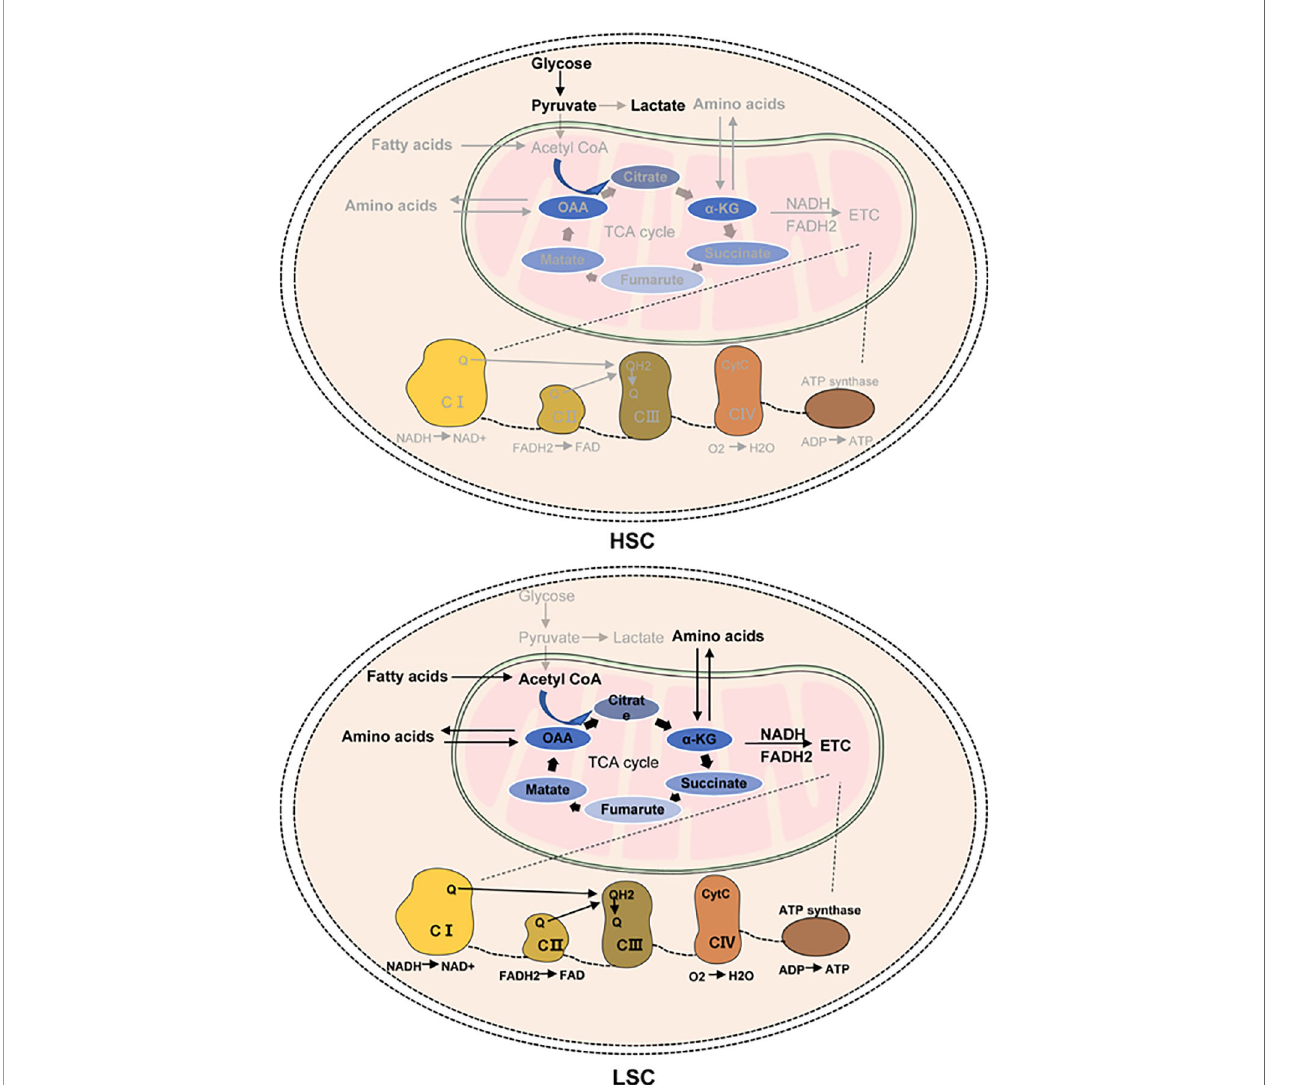
FIGURE 1 | The energy metabolism in HSCs and LSCs. LSCs mainly depend on OXPHOS for energy demand. OXPHOS is a fundamental mitochondrial process, linking the tricarboxylic acid (TCA) cycle to the production of ATP via the electron transport chain (ETC). In LSCs, glucose cannot enter the TCA cycle. Amino acids enter the TCA cycle through conversion to the TCA cycle intermediates (such as oxaloacetate (OAA) and alphaketoglutarate ( a -KG)). Fatty acids are converted to acetyl-CoA through b -oxidation in the mitochondria. The increased NAD+ levels from nicotinamide metabolism are necessary for the suf fi cient function of the TCA cycle enzymes. NADH and FADH2 produced from the TCA cycle generate ATP via ETC. TCA, tricarboxylic acid; ATP, adenosine triphosphate; acetyl-CoA, acetyl coenzyme A; CytC, cytochrome c; ETC, electron transport chain; Q, coenzyme Q/ubiquinone; QH2, ubiquinol; FADH2, fl avin adenine dinucleotide; NADH, nicotinamide adenine dinucleotide; CI, complex I; CII, complex II; CIII, complex III; CIV, complex IV; ADP, adenosine